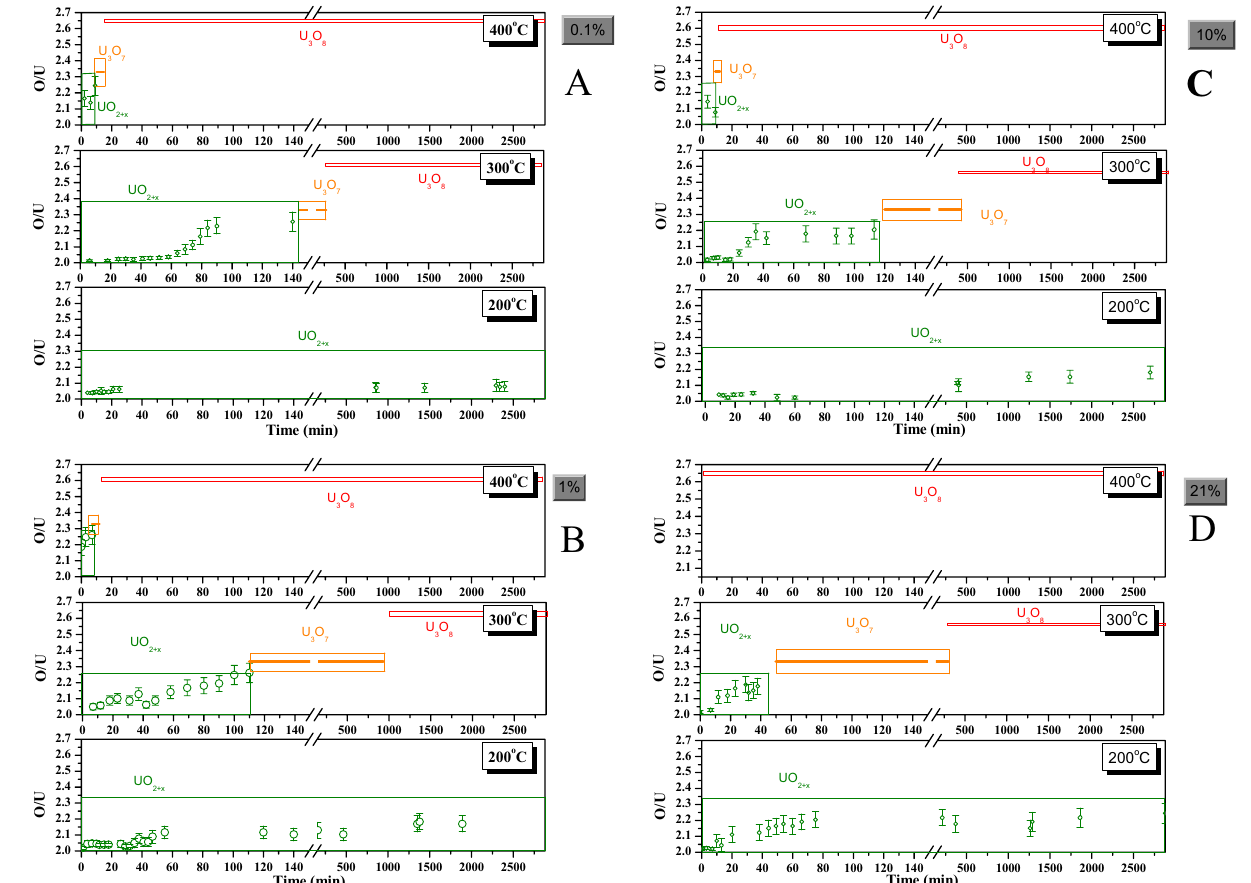
Figure 6. O/U ratio vs reaction time in the different temperatures and oxygen partial pressures